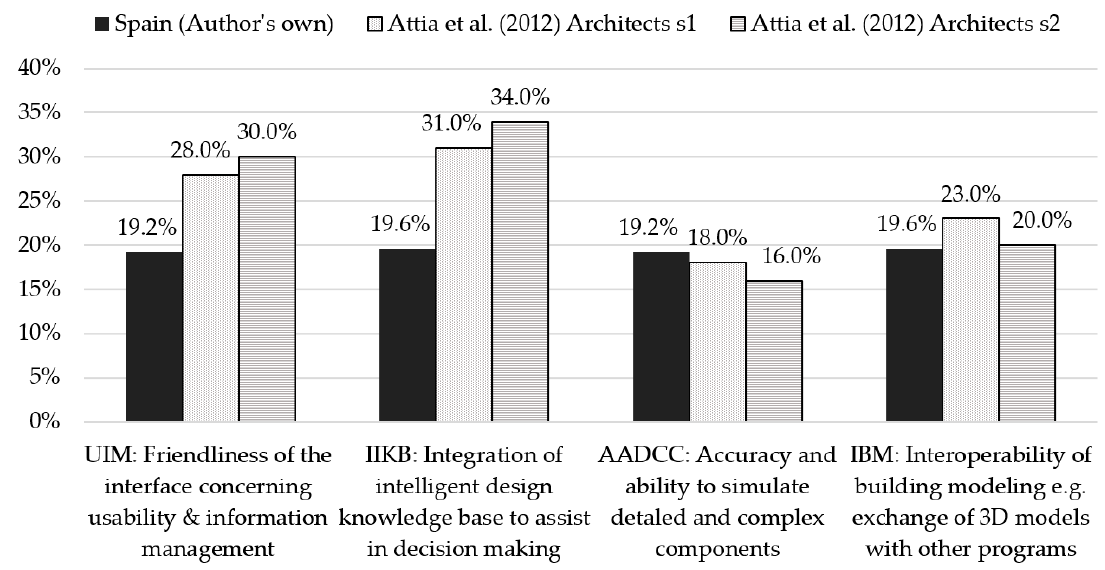
Figure 6. Priorities in selecting BPSTs. Comparison of the Spanish respondents considered in this study and those considered in the study of Attia, Shady et al., 2012. (Addressed only to BPSTs users).